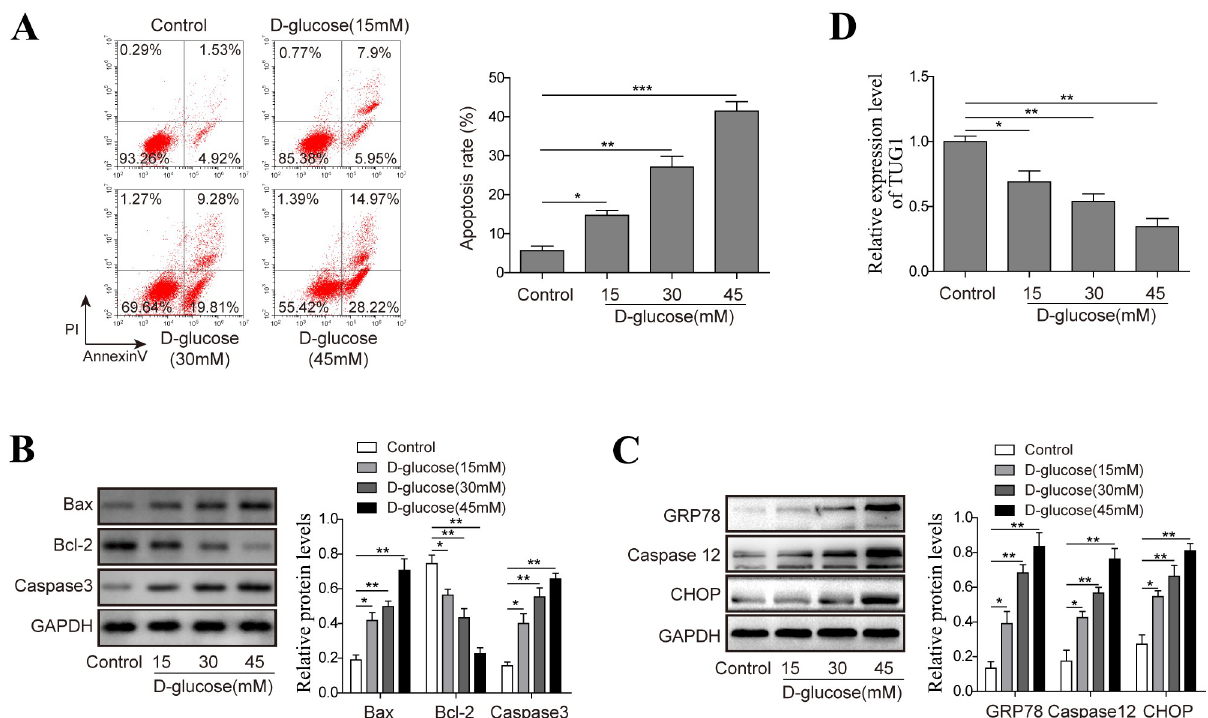
Fig 1. High glucose (HG) challenge induces apoptosis, ERS and downregulates TUG1 expression in HK-2 cells. (A) HK-2 cells were treated different concentrations (15, 30, 45 mM) of D-glucose for 48 h, cell apoptosis was examined by flow cytometry. (B) The protein levels of indicated proteins (Bax, Bcl-2, Caspase3) were evaluated by western blot, respectively. (C) The expression of ERS-related proteins (Caspase12, GRP78, CHOP) were measured by western blot. (D) HK-2 cells were treated with 15, 30, 45 mM D-glucose for 48 h, the level of TUG1was evaluated by real-time PCR. Data were mean ± SD and were representative of three independent experiments. � p < 0.05, �� p < 0.01, ��� p < 0.001.